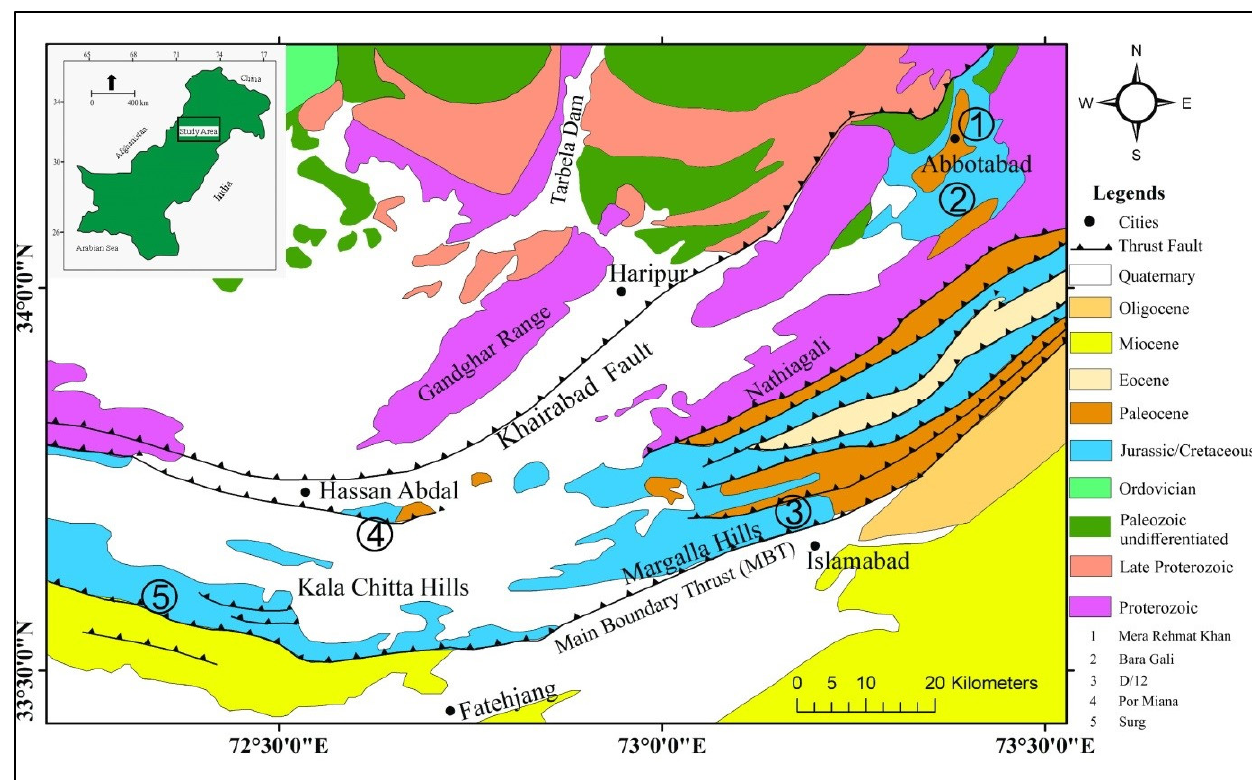
Figure 1. Geological map of the study area showing the location of studied sections modified from Searle et al. [27]